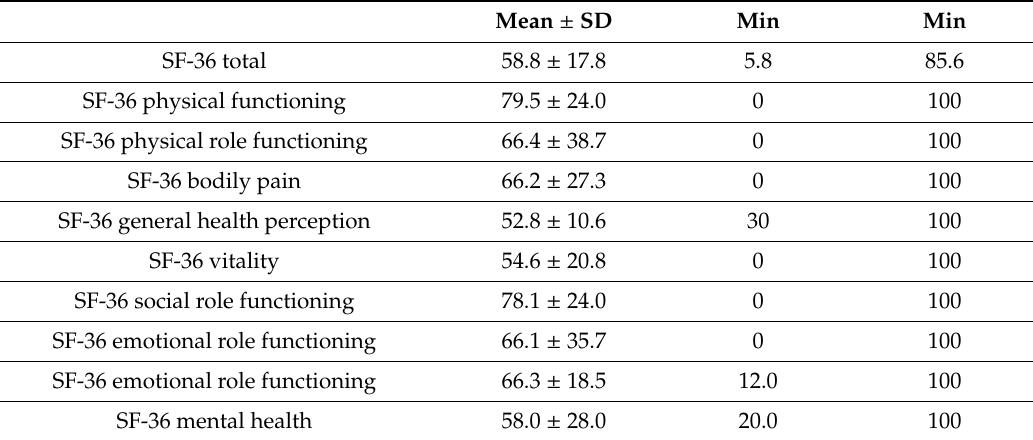
Table A1. Detailed SF-36 subscores of the caregivers ( n =